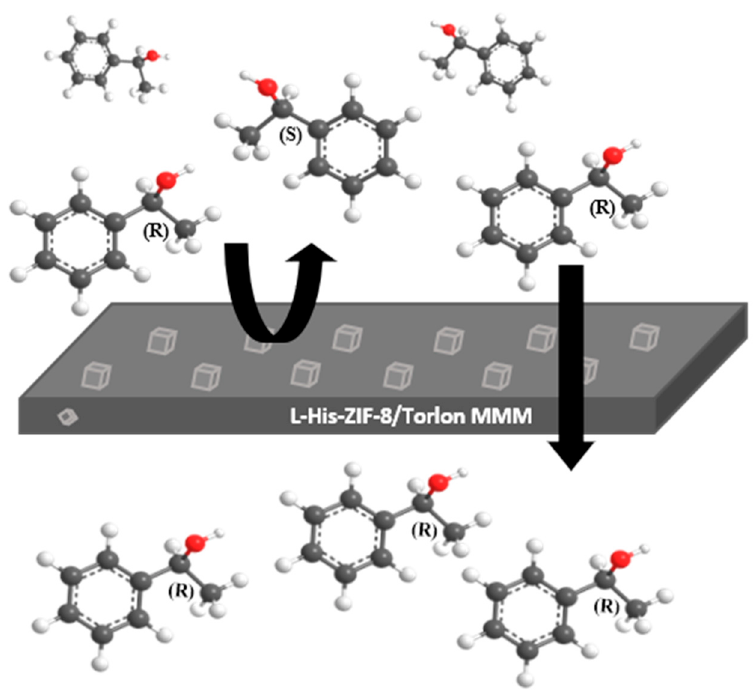
Figure 1. Scheme of the racemic 1-phenylethanol resolution in the L-His-ZIF-8/Torlon ® mixed-matrix membrane.